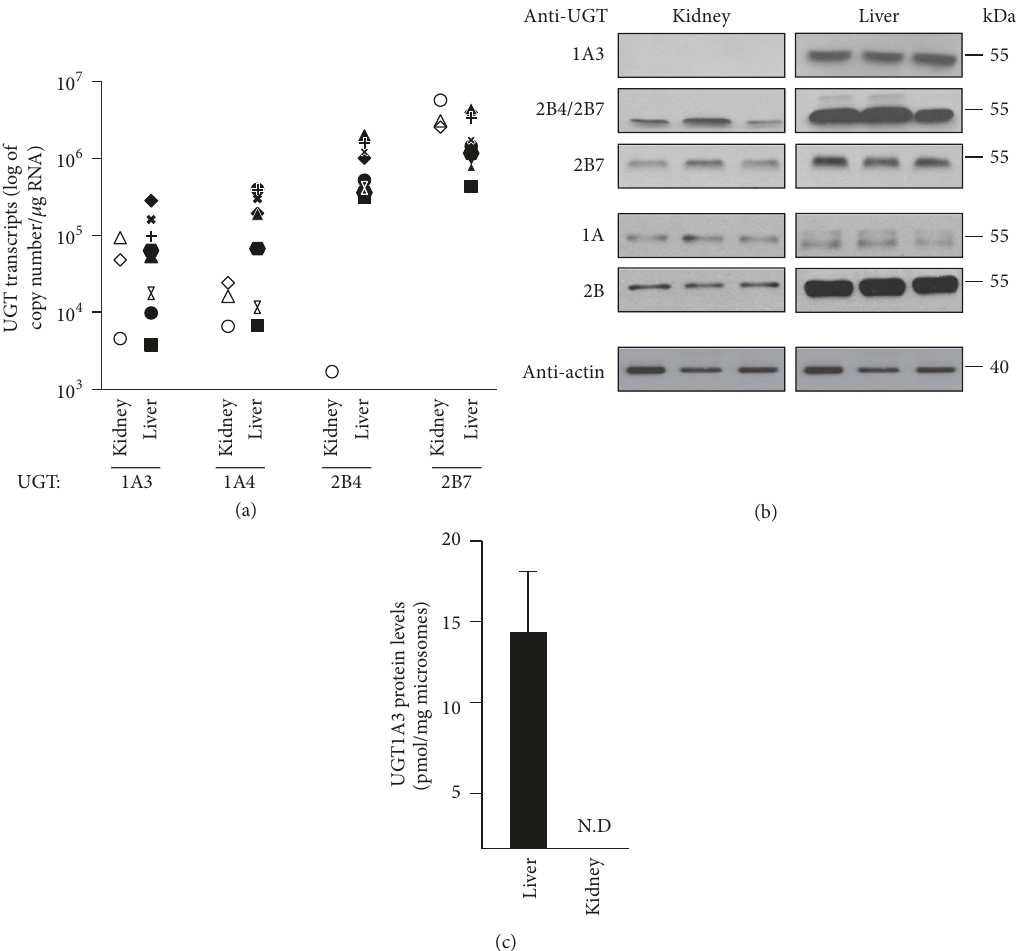
Figure 6: Differential expression of the bile acid-conjugating UGT enzymes in the human liver and kidney. (a) UGTs 1A3, 1A4, 2B4, and 2B7 mRNA levels in total RNA samples from human kidney (1 pool of 5 donors and 2 individual donors) and liver (8 individual donors) were determined through qRT-PCR analyses as described in “Materials and Methods.” Results are expressed as log 10 of mRNA copy number per 𝜇 g of total RNA. Each symbol represents 1 donor, with the exception of the white triangle that corresponds to a pool of the 5 kidney donors. (b) The UGT protein contents in microsomal preparations (5 𝜇 g) from human kidney (pool of 4 female and 4 male donors) and liver (pool of 26 male and 24 female donors) were determined after size separation on SDS-PAGE and hybridization with the anti-UGT1A3, anti-UGT2B4/7, anti-UGT2B7, anti-UGT1A, and anti-UGT2B antibodies (1: 2,000 dilution). The housekeeping protein 𝛽 -actin was used to ensure the equal protein loading in each lane. Data presented are representative of two experiments. (c) The UGT1A3 protein content in human liver and kidney microsomes was determined using LC-MS/MS analyses as previously described [10]. Data represent the mean ± SD of two different experiments performed in triplicate. N.D: not